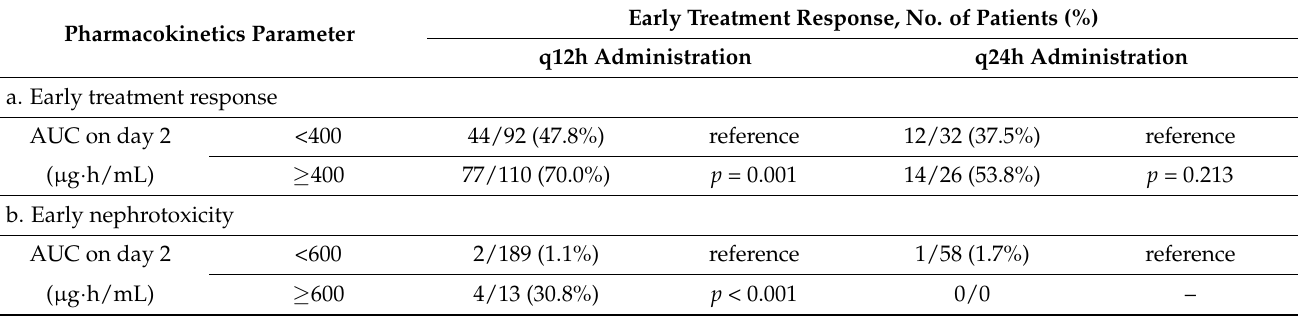
Table 4. Early treatment response and early occurrence of nephrotoxicity according to each cutoff AUC on day 2 in patients with vancomycin q12h and q24h administration.